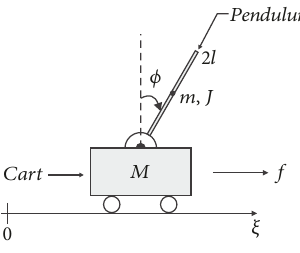
Figure 1: Inverted pendulum on a